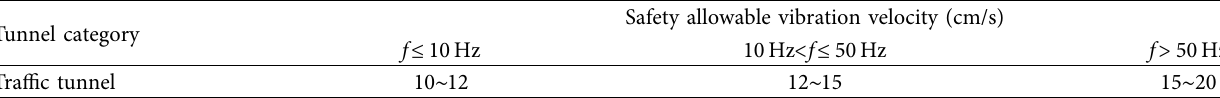
Table 2: Safety allowable standard of blasting.